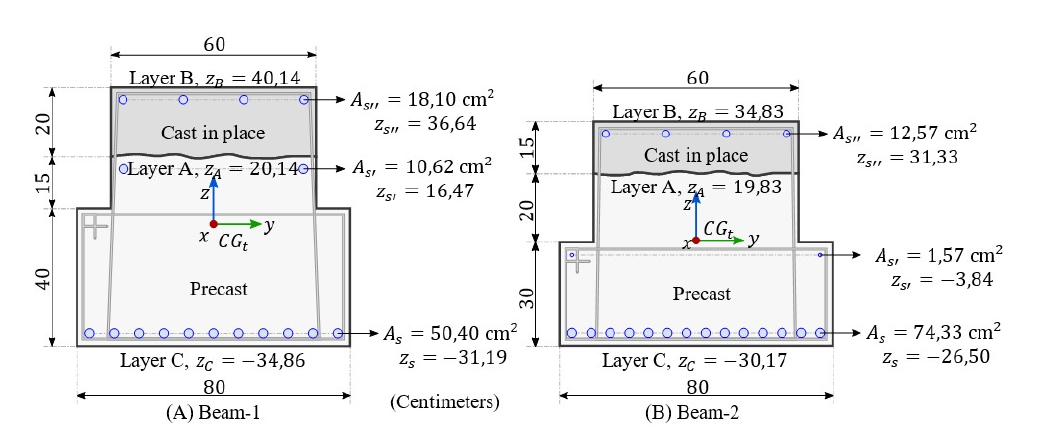
Figure 13. Cross-section of beam-1 and beam-2.